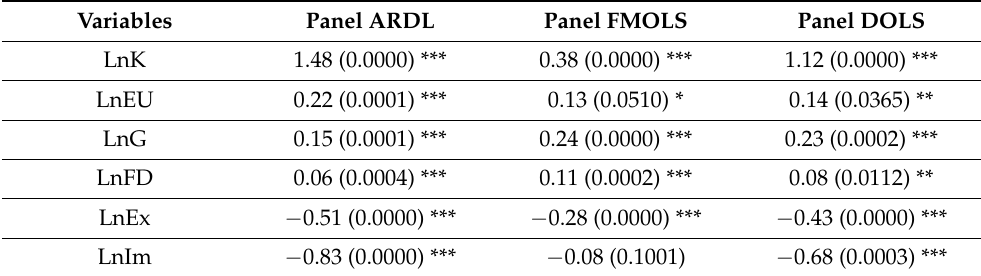
Table 7. Sensitivity check of Panel ARDL by Panel FMOLS and DOLS.